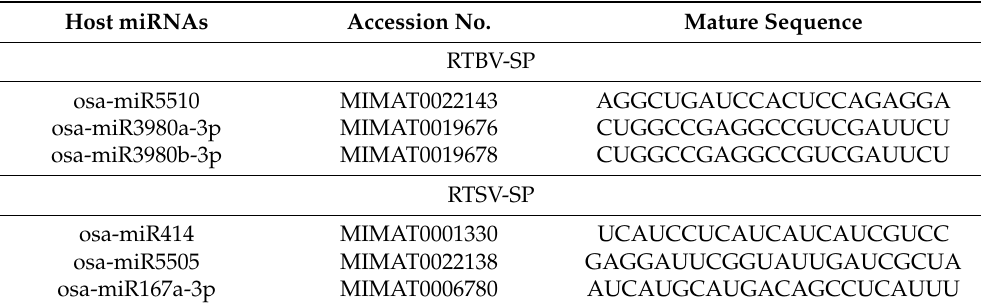
Table 3. The best host-derived miRNAs target the RTBV and RTSV genomes and their mature sequence.